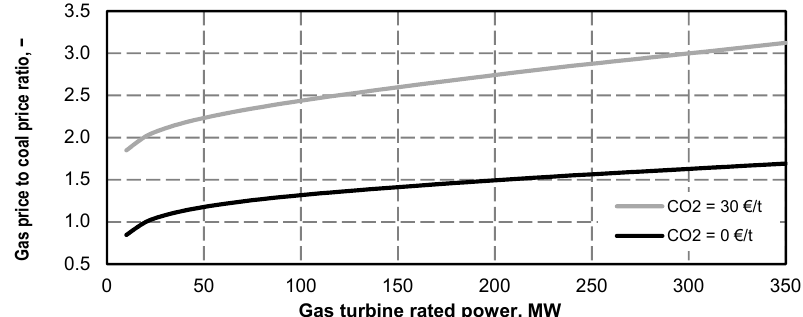
Figure 50 The ratio of unit gas price to unit coal price providing the viability of adding the superstructure of gas turbine and single-pressure recovery boiler as a function of gas turbine rated power for operating the gas turbine with shutting off during the night low power load (“night valley”) ( e c = 9.52 PLN/GJ). For operating the superstructured power unit with shutting o ff the gas turbine during a lower power demand period (“night valley”) the gas price that provides economic viability for the 350 MW gas turbine is 1.7 × 10 PLN / GJ = 17.0 PLN / GJ, which is much below the current gas price. However, if the price of carbon dioxide emission permits increases to 30 EUR / t, and the cost of power generation increases